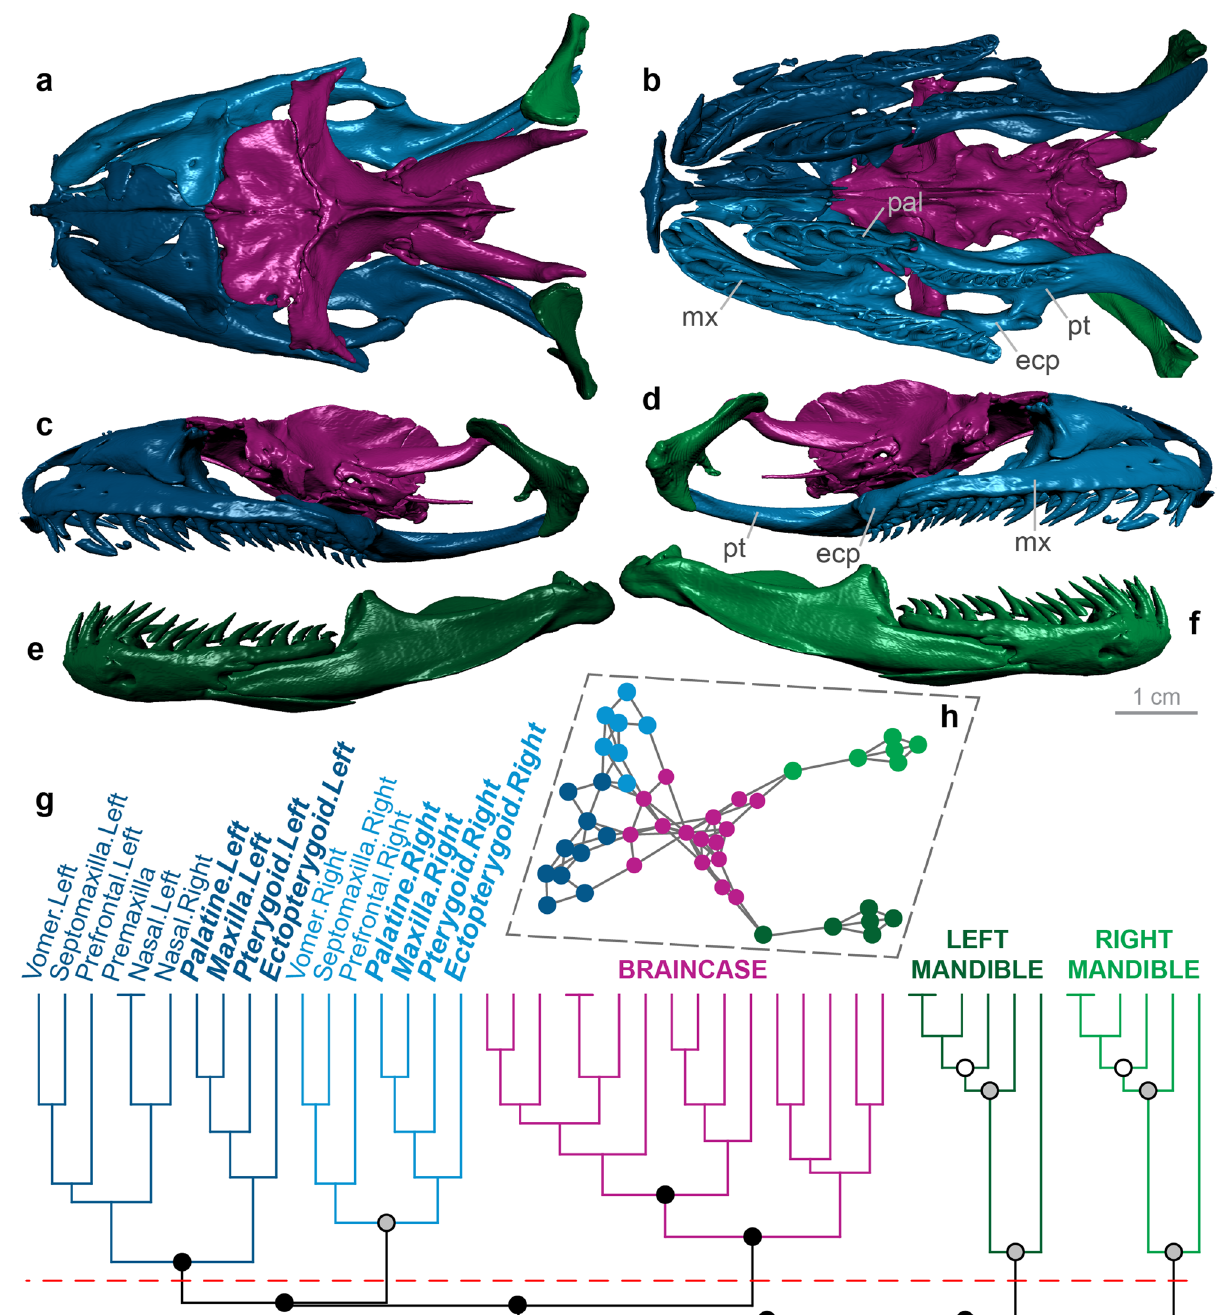
Figure 7. Skull modularity of booid-pythonoid snakes. In booid-pythonoids, the palatomaxillary elements (in italicized boldface) and prefrontals consistently form left and right modules, often alongside some or all of the snout elements. ( a–f ) Representative pattern of booid-pythonoid skull modularity, illustrated using Boa constrictor (FMNH 31182) in ( a ) dorsal, ( b ) ventral, ( c ) left lateral, and ( d ) right lateral views of the skull, and ( e ) left lateral and ( f ) right lateral views of the mandible. ( g ) Network dendrogram of Boa , reflecting this network architecture. Q-modules are indicated by Q max (represented by the red dotted line). S-modules are indicated by black (p < 0.001), grey (0.001 ≤ p < 0.01), or white (0.01 ≤ p < 0.05) circles. ( h ) Network representation of the skull of Boa (see Supplementary Fig. S58 for labelled version). ecp ectopterygoid, mx maxilla, pal palatine, pt pterygoid. Dendrogram and network generated in R [v.4.0.3] 122 and RStudio [v.1.3.1093] 123 (see “Methods” section); specimen visualized in Dragonfly [v.4.1] 114